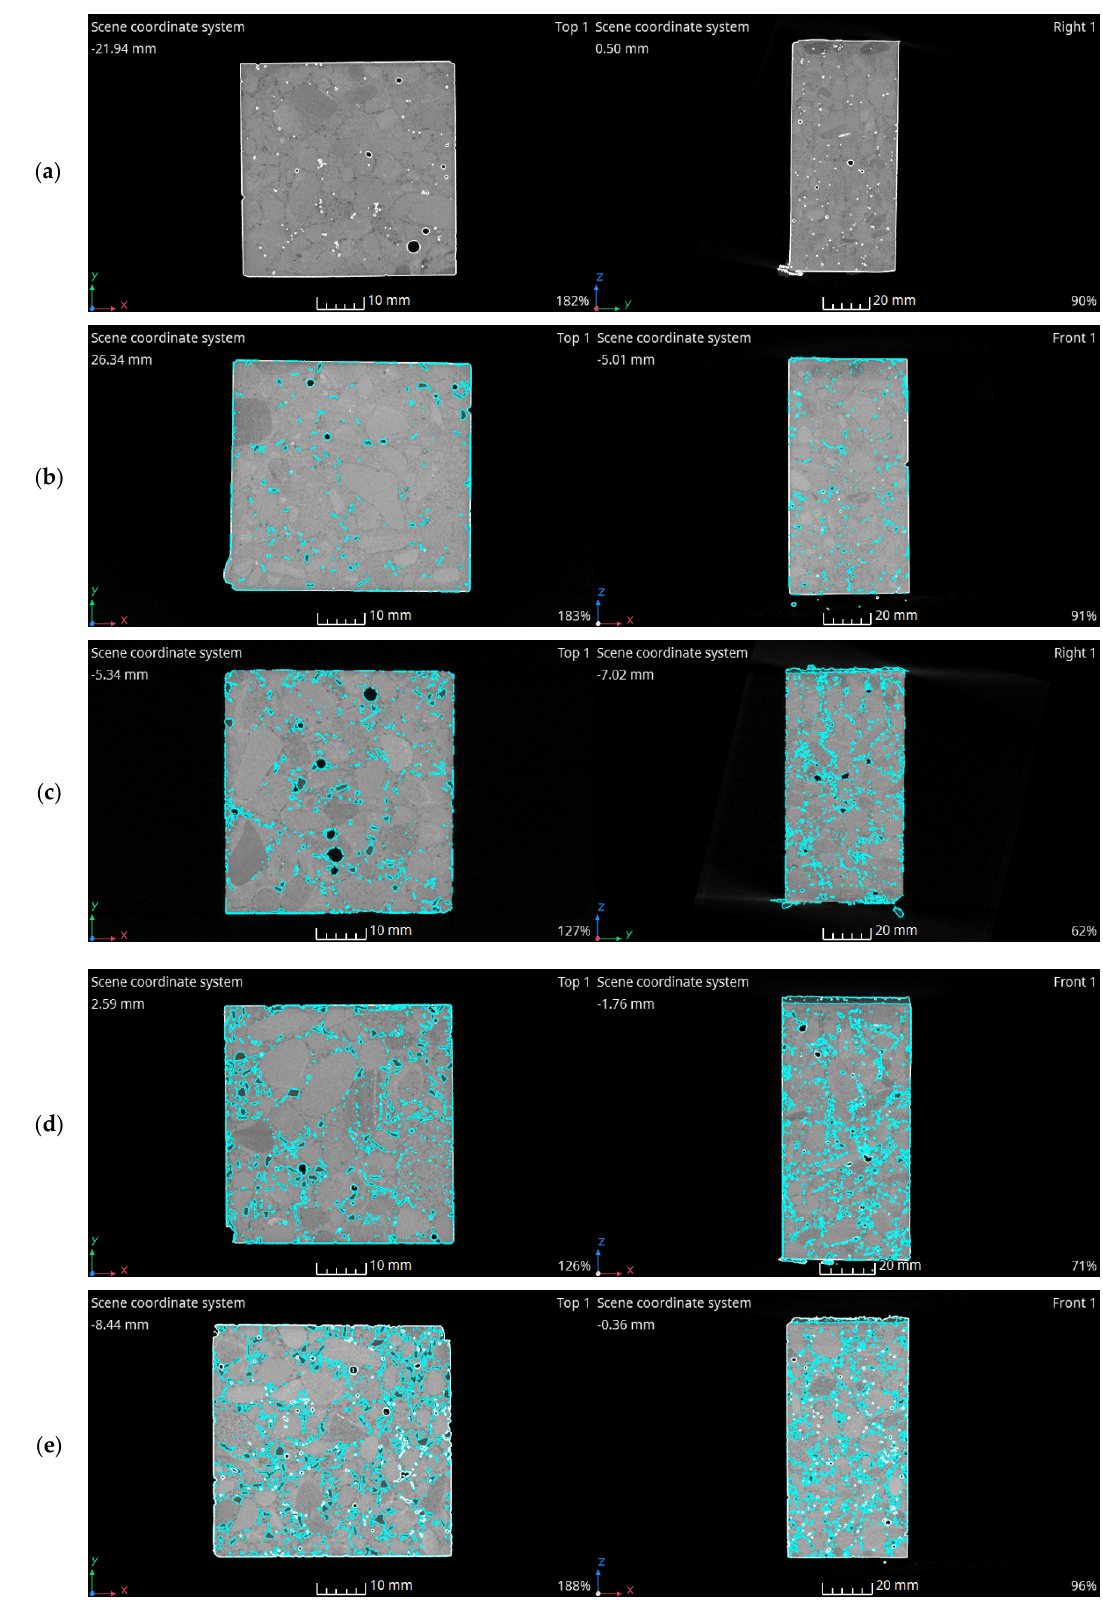
Figure 6. X-ray CT scans—identification of PET flakes in a concrete sample: ( a ) SCC-P-0, ( b ) SCC-P-5, ( c ) SCC-P-10, ( d ) SCC-P-15, and ( e ) SCC-P-20.